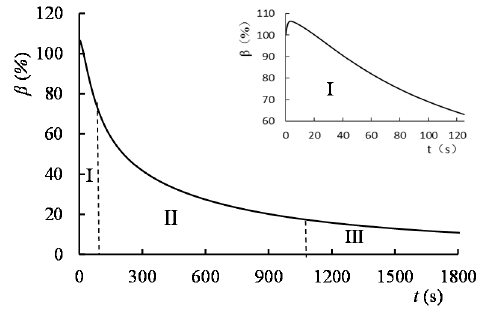
Figure 14. The ESR ( β )—time ( t ) relationship curves.